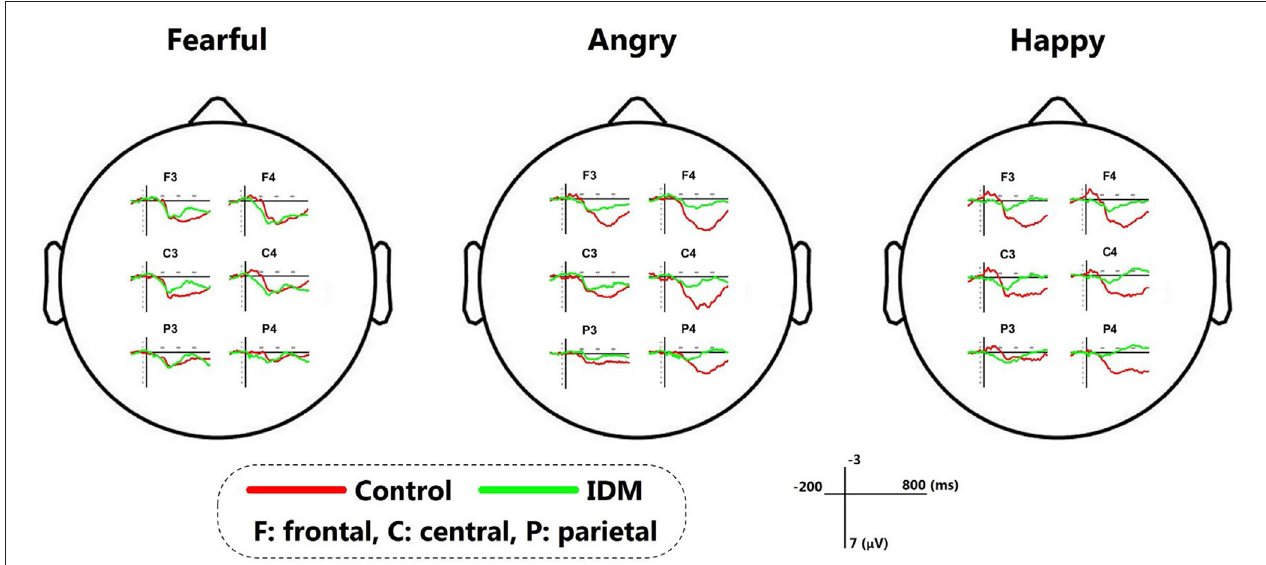
FIGURE 2 | The MMR of IDM and control group stimulated by fearful/angry/happy prosodies.